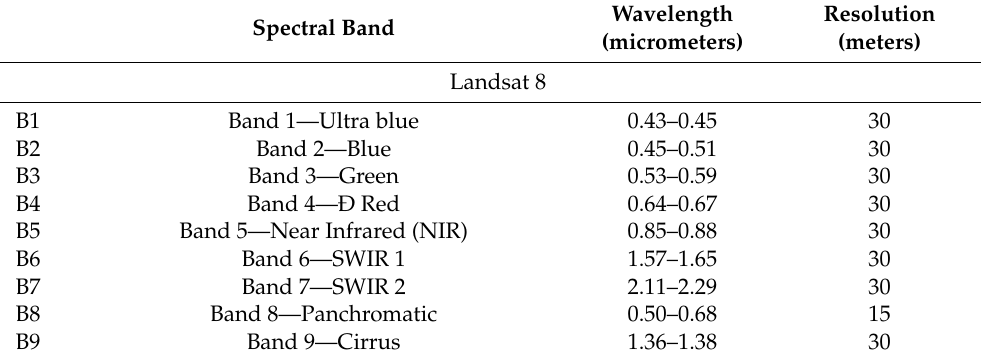
Table A2. Description of spectral bands from Landsat-8 and WorldView-2/WorldView-3 used in classification. Spectral